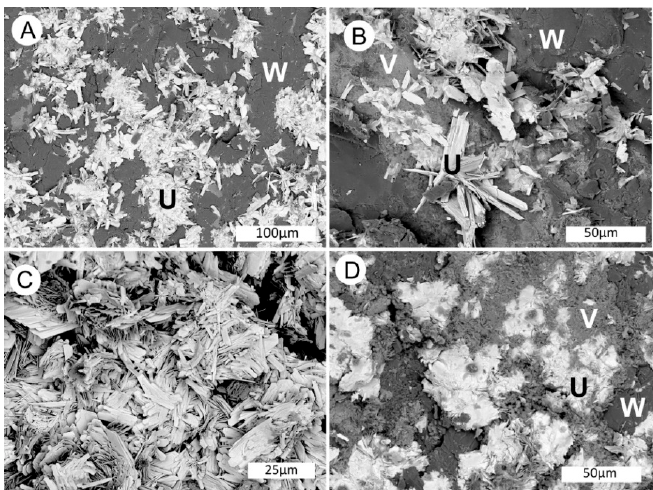
Figure 19. SEM backscatter electron images show bright crystals of tyuyamanite (labeled U ) within dark silicified wood (labeled W). ( A,B ) Radiating crystals of tyuyamunite on fossil wood. ( C ) Mass of pure tyuyamunite. ( D ) Tyuyamunite and a vanadium mineral ( V ) incorporated within fossil wood.